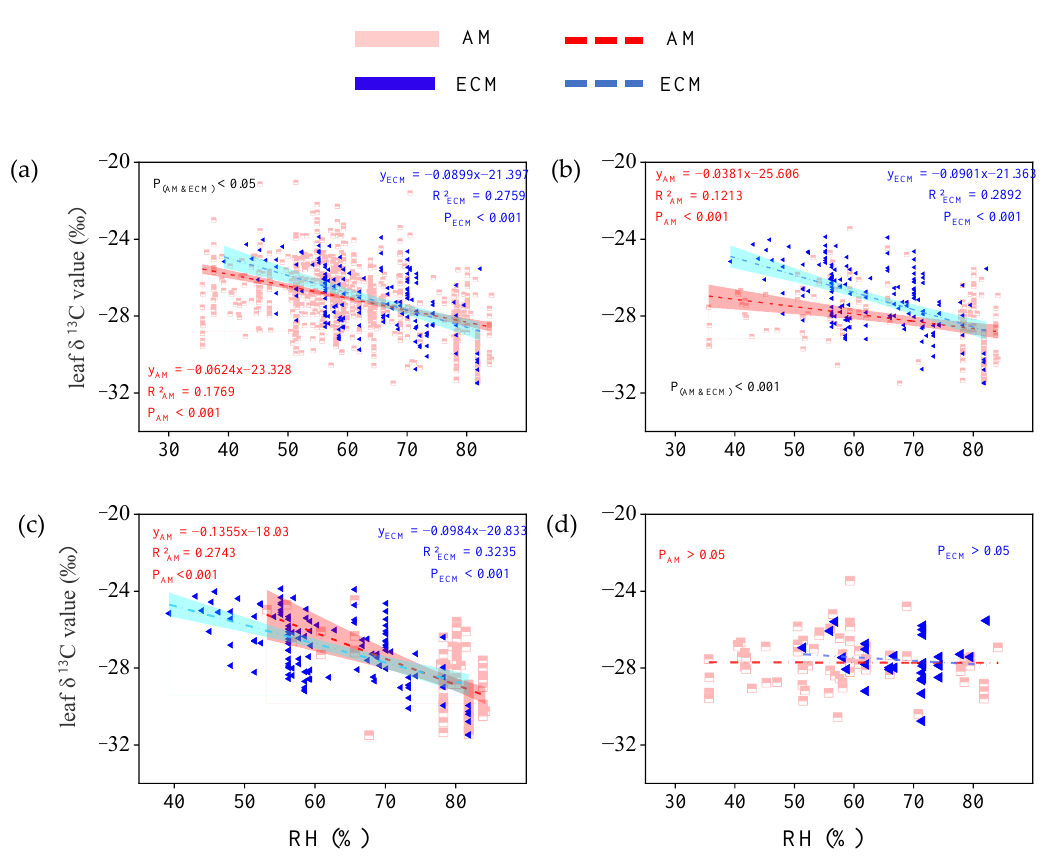
Figure 6. The relationship between leaf δ 13 C in AM plants and ECM plants with different life forms and relative humidity (RH, %). ( a ) Total plants, include all plants in the database with- out distinguishing their life forms. ( b ) Trees, only contain all the tree species in the database. ( c ) Evergreen trees, only contain all evergreen trees of the tree species. ( d ) Deciduous trees, only contain all deciduous trees of the tree species. The red broken line means AM, the blue broken line means ECM. The red and cyan bands represent, respectively, the prediction intervals of AM and ECM plants. P(AM and ECM) represents the significant difference in the slope of the two regression